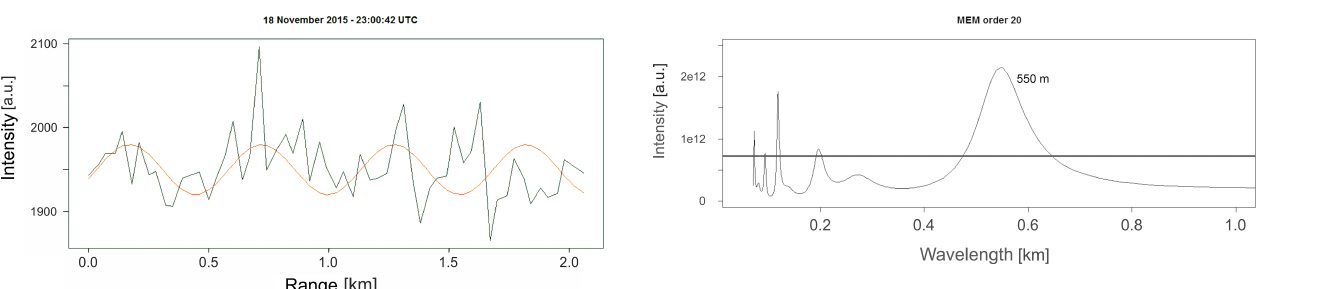
Figure 4. MEM spectrum (of the order of 20) of the data series shown in Fig. 3. The horizontal line marks the 99% level of signif- icance. The peak of the 550m wave packet is clearly recognizable.